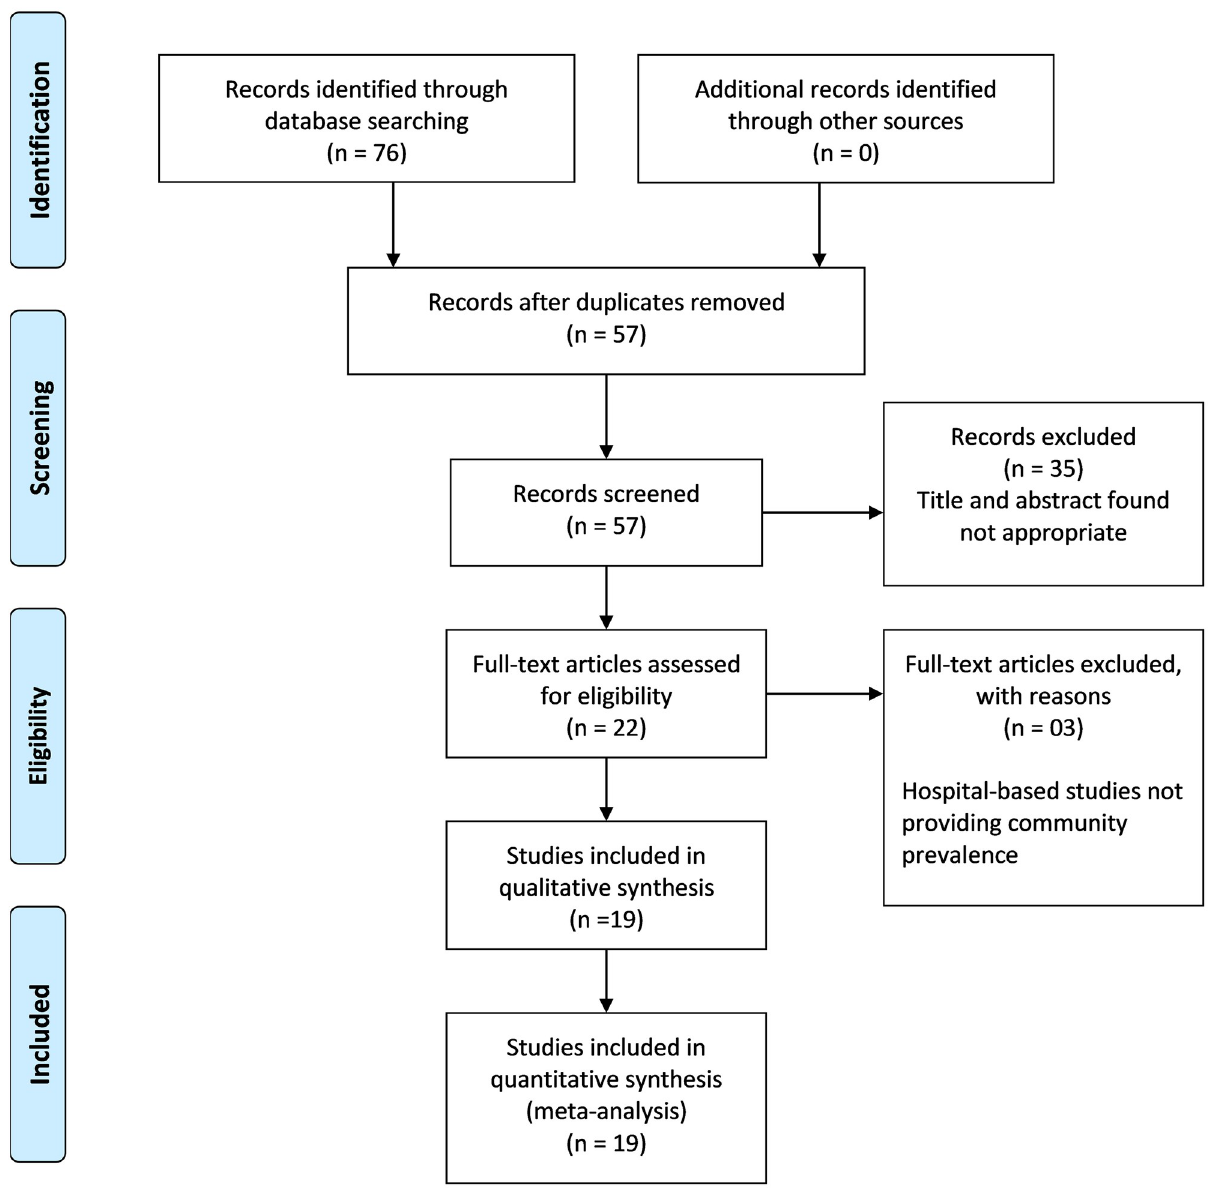
Fig 1. Flow chart of study